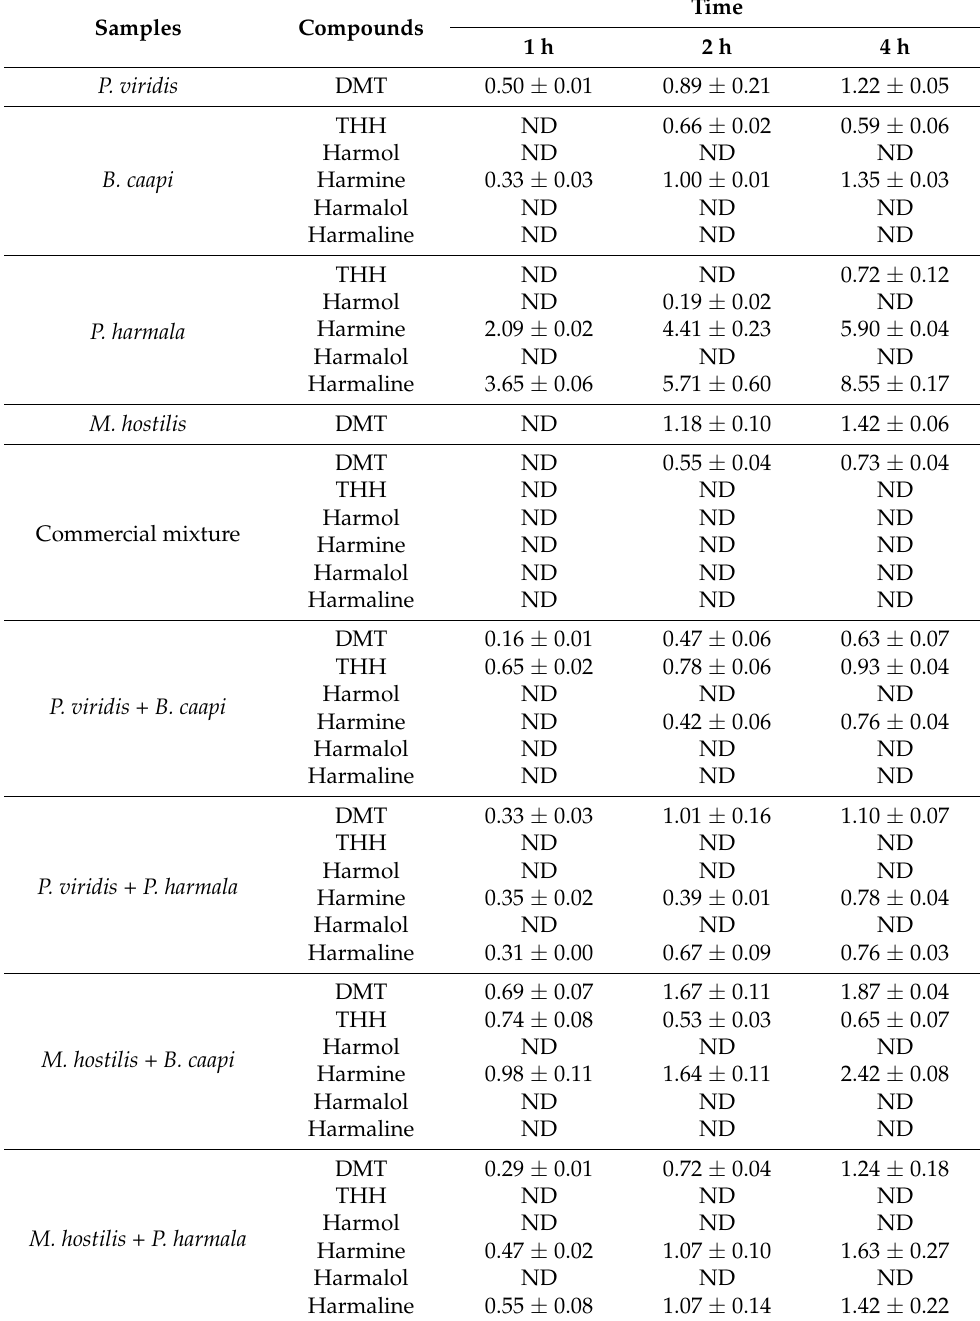
Table 6. Concentration of the main compounds of Ayahuasca in the aliquots collected after the different incubation times with the crude extract (Mean µ g/mL Extract) ±